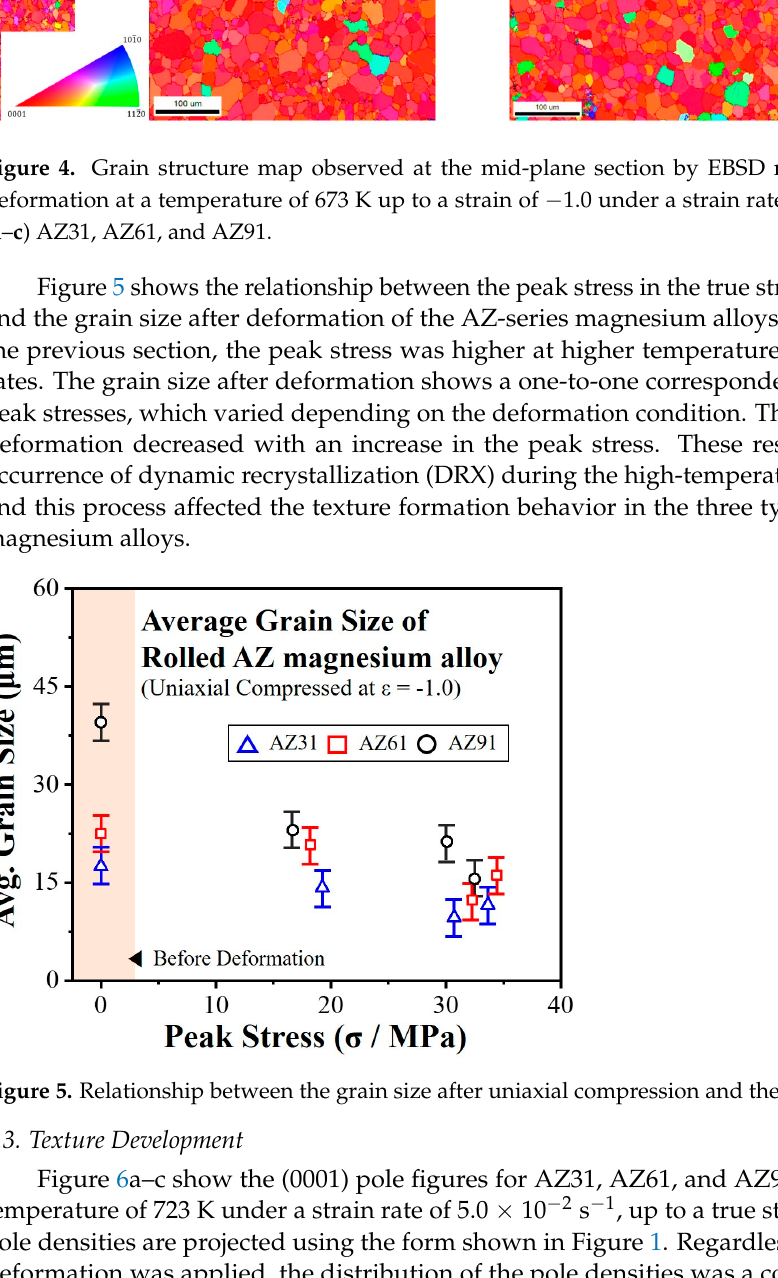
Figure 5. Relationship between the grain size after uniaxial compression and the peak stress.